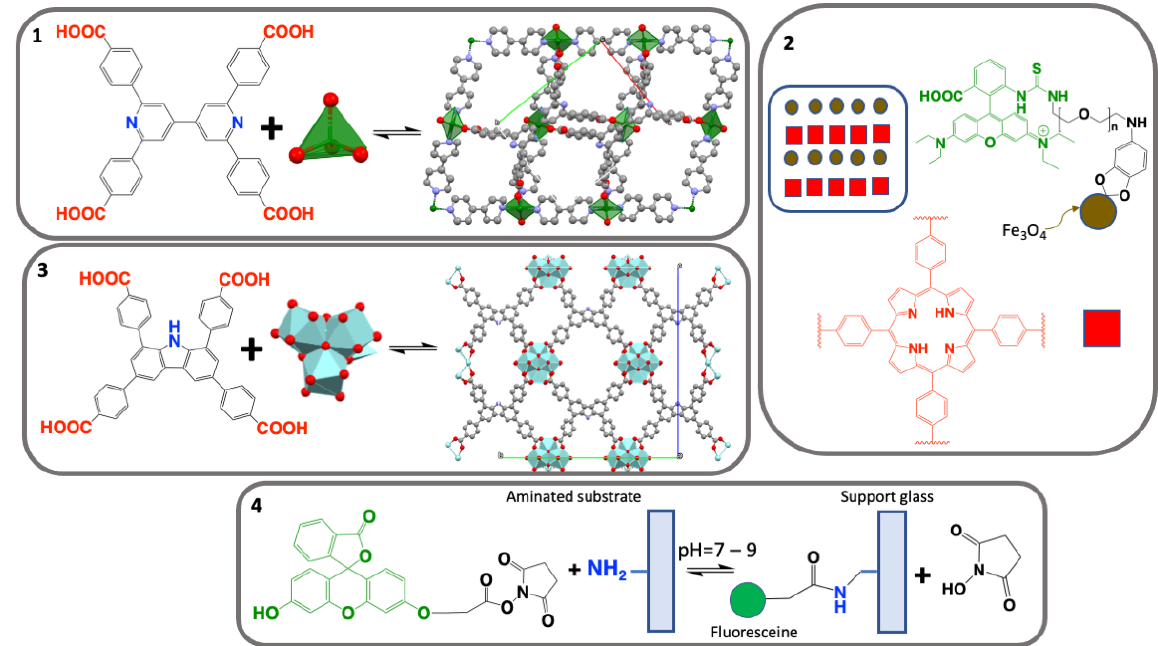
Figure 2. Recent nano-sized visual pH sensors. Box 1. MOF obtained from bipyridyl-tetracarboxylic in complex with Zn(II)-oxo specie derivative (green tetrahedral pyramid, oxygen red spheres, nitrogen blue spheres). Three-dimensional structure is obtained from Cambridge Structural Database (CSD) [83] with accession code 2019034 [84] Box 2. A nanocom- posite pH VS is obtained from rhodamine B bound to a 3,4-dihydroxybenzaldehyde-polyethene glycol amino (DBI-PEG- NH 2 ) functionalized with Fe 3 O 4 (colored brown sphere) [85]. This composite is then mixed to meso -tetra (4-carboxyphenyl) porphyrin (red squares), and the overall mixture dispersed into a zirconium-based MOF (highlighted box) [86]. Box 3. MOF named BUT-62 is obtained from a fluorescent asymmetric ligand mixed to a zirconium oxo-complex (Zr cyan-poly- hedron, O red spheres, N blue spheres; accession code 1446514) Box 4. pH VS from highly engineered nanomaterials. A “grafting” reaction causes binding of fluorescein molecule, as succinimidyl ester, to a glass (semi-transparent blue rectan- gle) coated with (3-aminopropyl)trimethoxysilane (APTMS, blue segment) [87]. Adapted from references indicated in square brackets.